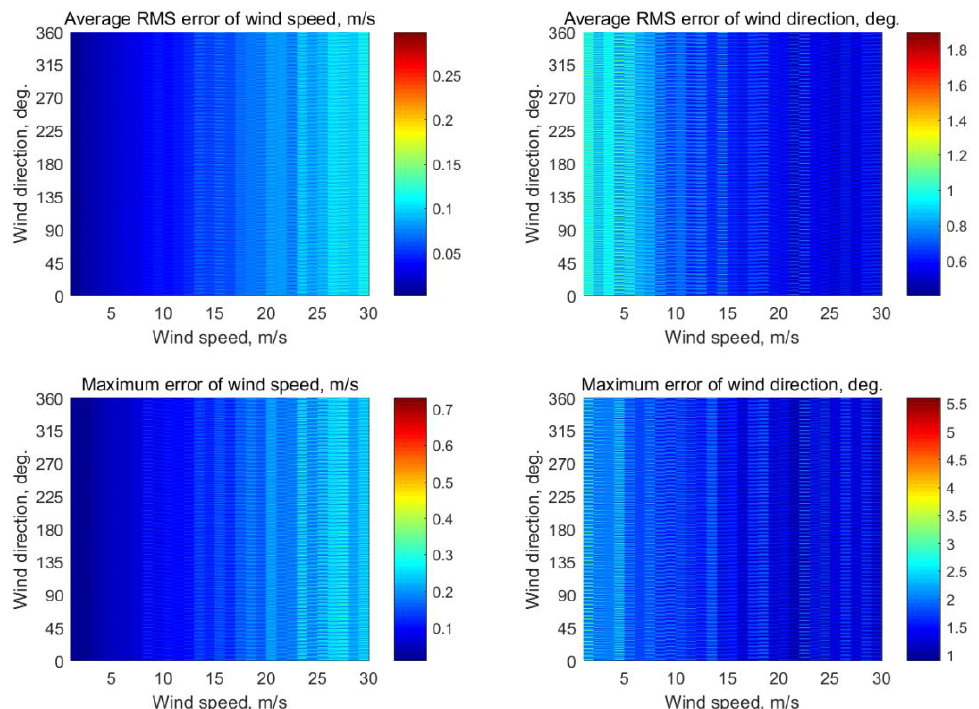
Figure A22. Simulation results of the use of four incidence angles of 45 ◦ , 50 ◦ , 55 ◦ , and 60 ◦ for wind retrieval.